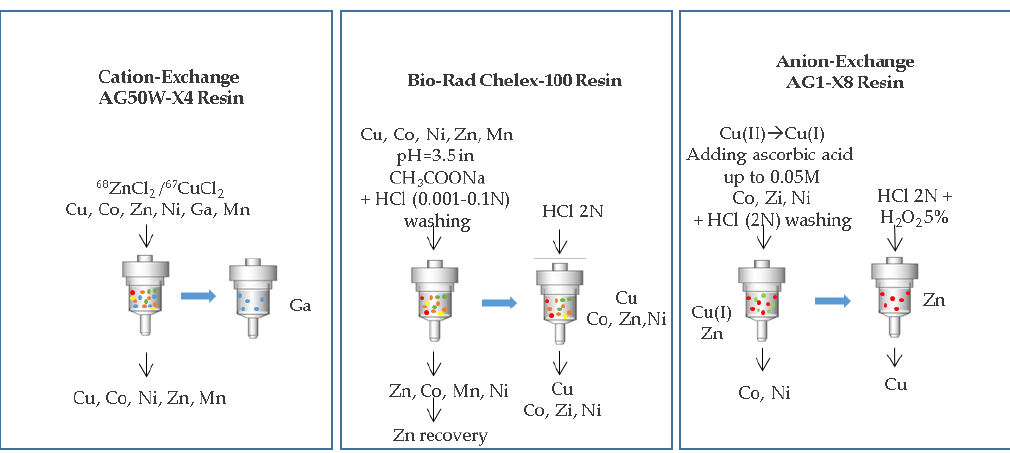
Figure 3. Schematic representation of the separation of copper isotopes from zinc and gallium contaminants reported by Medvedev et al. [53].